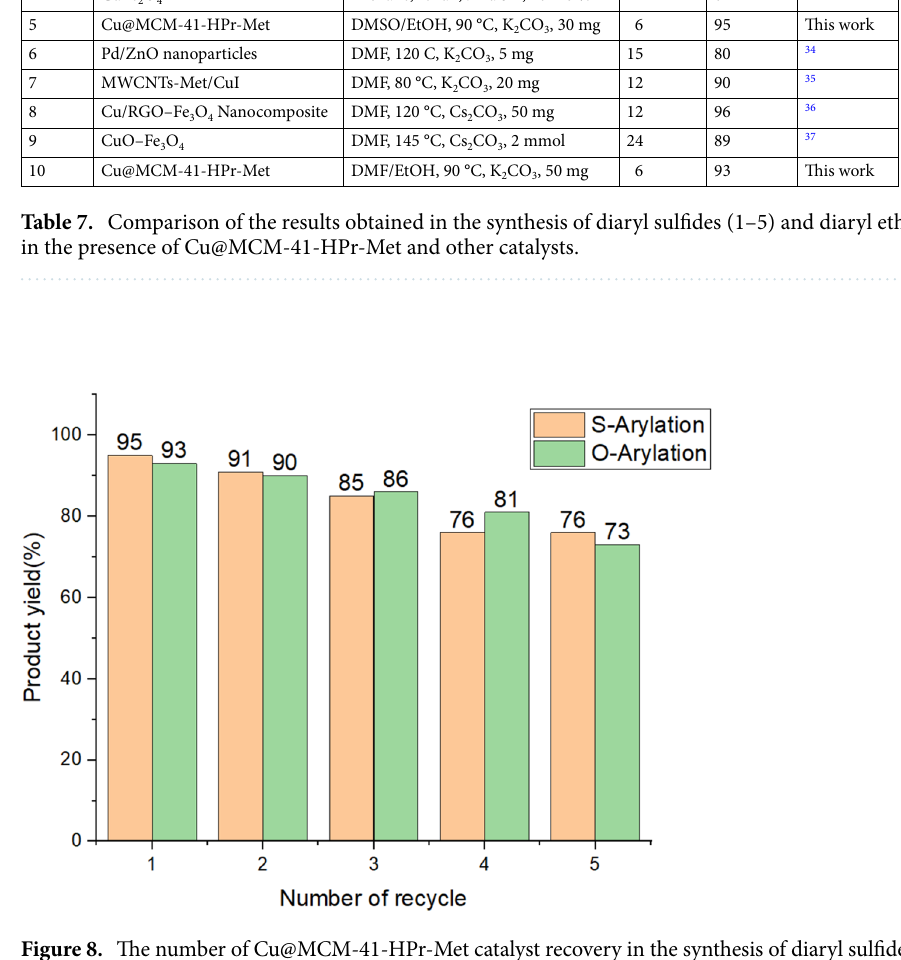
Figure 8. The number of Cu@MCM-41-HPr-Met catalyst recovery in the synthesis of diaryl sulfides and diaryl